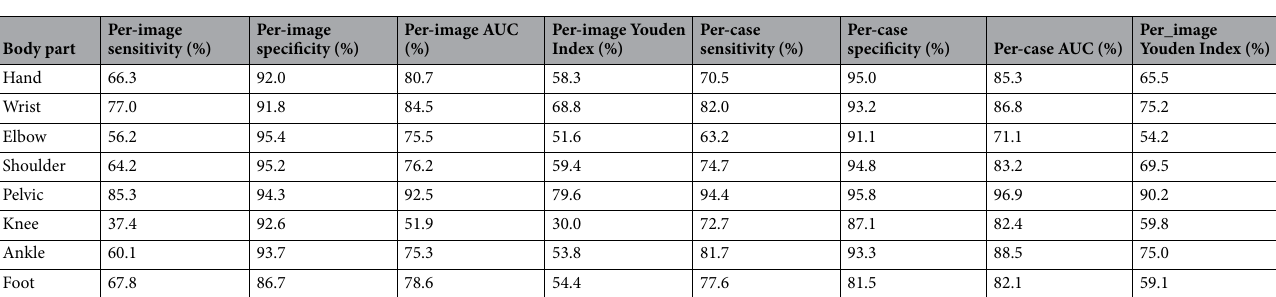
Table 4. Body-part specificity and sensitivity data. AUC, area under the